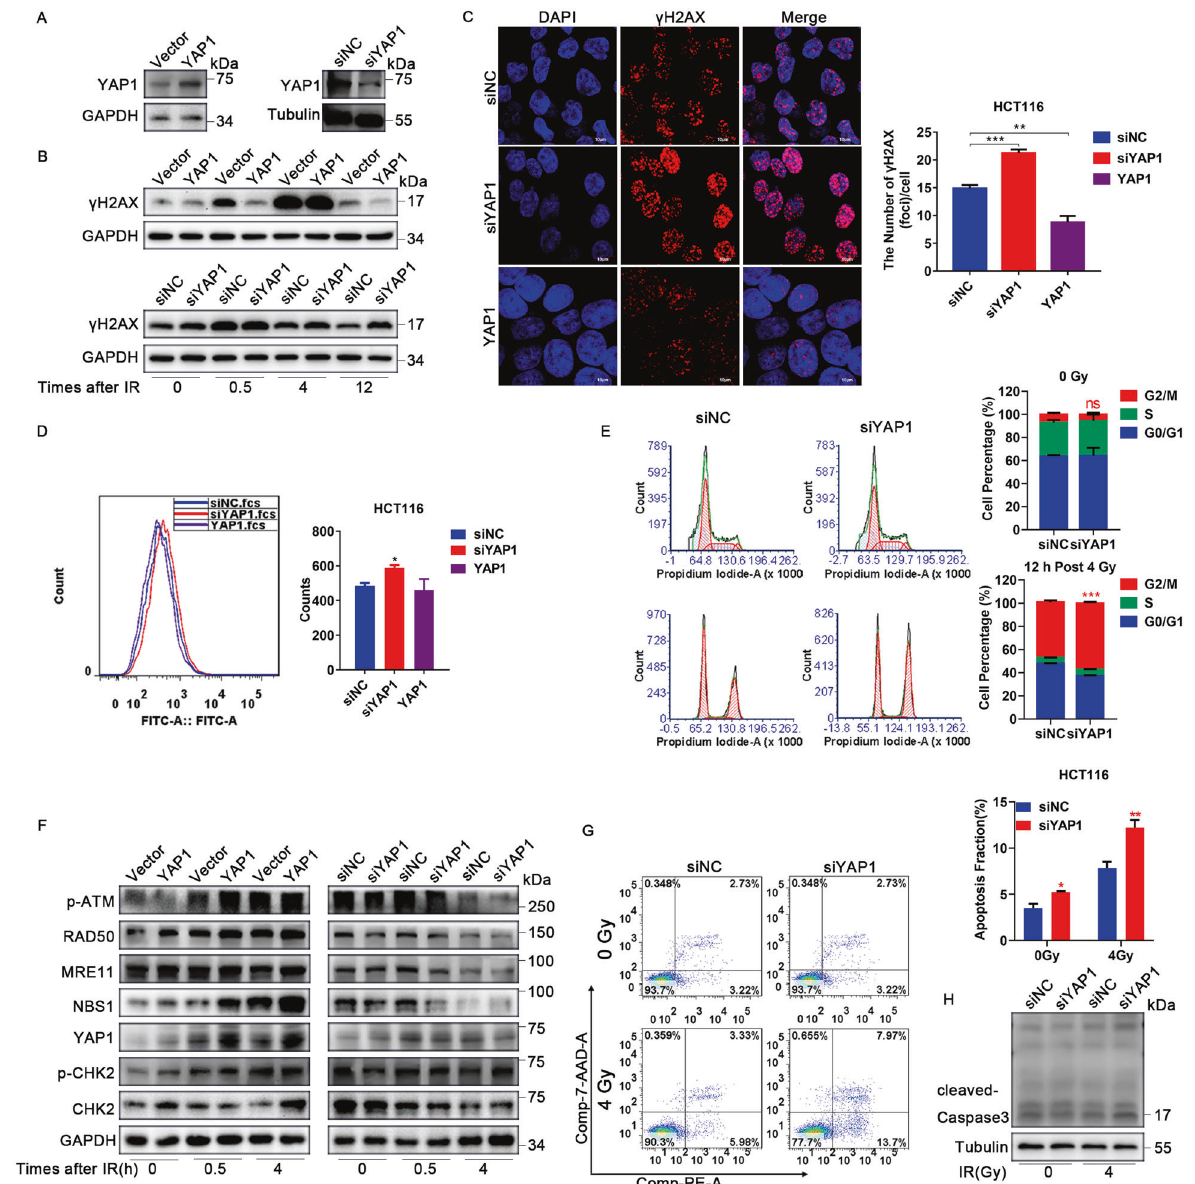
4 Gy IR in HCT116 cells with upregulated or downregulated expression of YAP1. C γ H2AX foci were detected by immuno fl uorescence at 0.5 h post IR in HCT116 cells with upregulated or downregulated expression of YAP1, and the number of γ H2AX foci was counted in more than 100 cells (** P < 0.01). D YAP1 expression affected the formation of ROS in HCT116 cells (* P < 0.01). E Downregulation of YAP1 induced cell arrest in G2/M phase at 12 h post IR (*** P < 0.001). F The expression of p-ATM, RAD50, MRE11, NBS1, YAP1, p-CHK2, and CHK2 was tested by Western blot at 0, 0.5, and 4 h post IR in HCT116 cells with upregulated or downregulated expression of YAP1. G Downregulation of YAP1 increased apoptosis at 48 h post IR, and the data are presented as the mean ± SD (* P < 0.05, ** P < 0.01). H Downregulation of YAP1 increased the expression of cleaved-caspase 3 at 48 h post